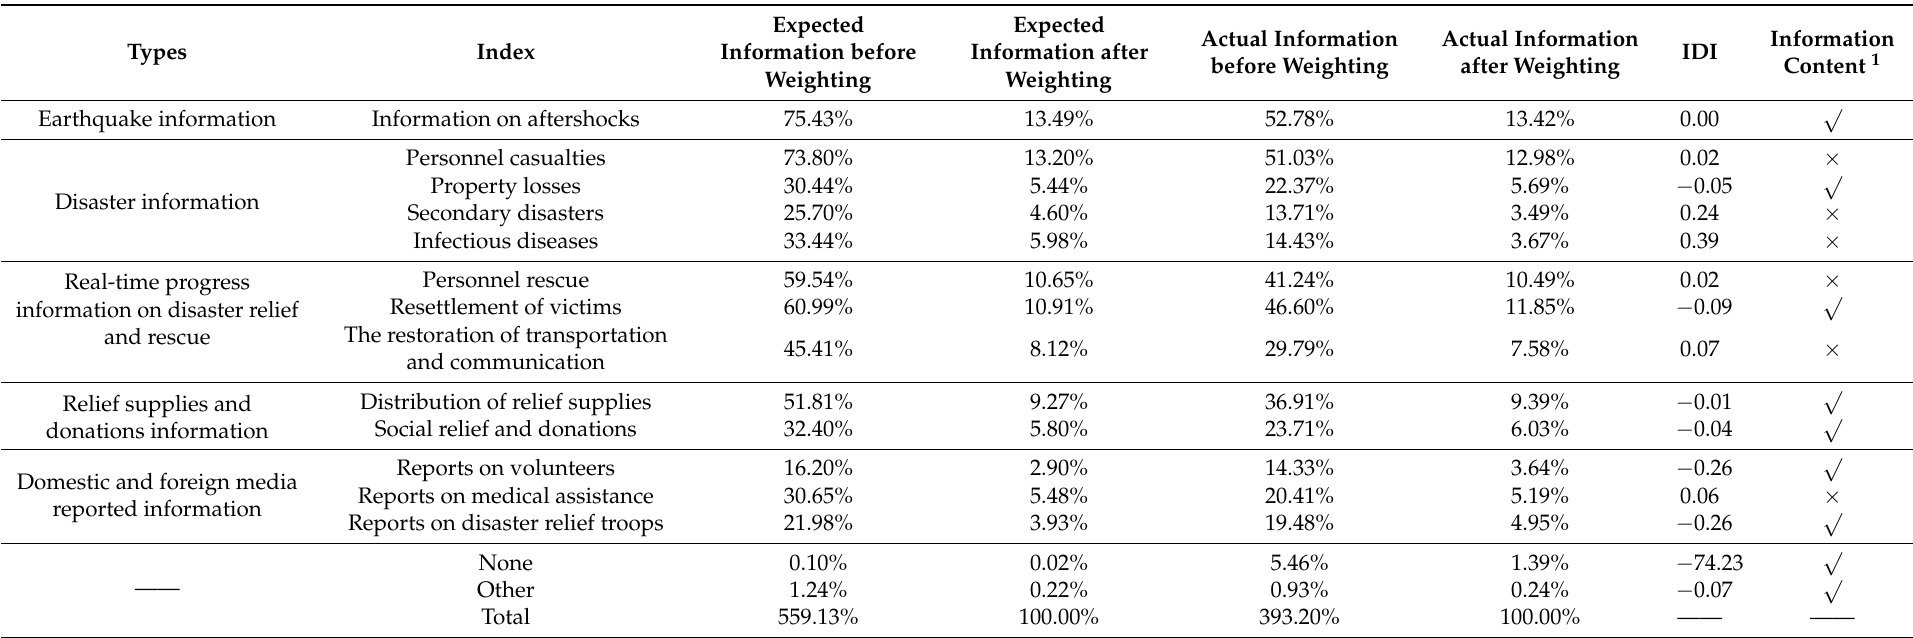
Table 6. Information deviation index in the chronic stage of an earthquake